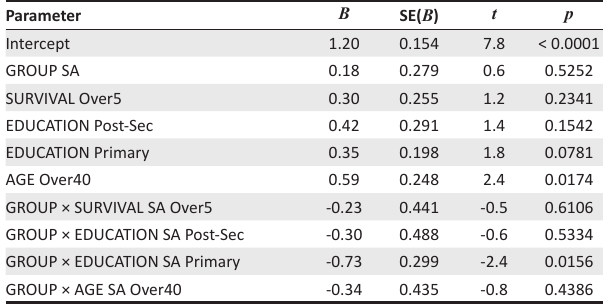
TABLE 12: Parameter estimates for two-way interaction analysis of variance model of market research.